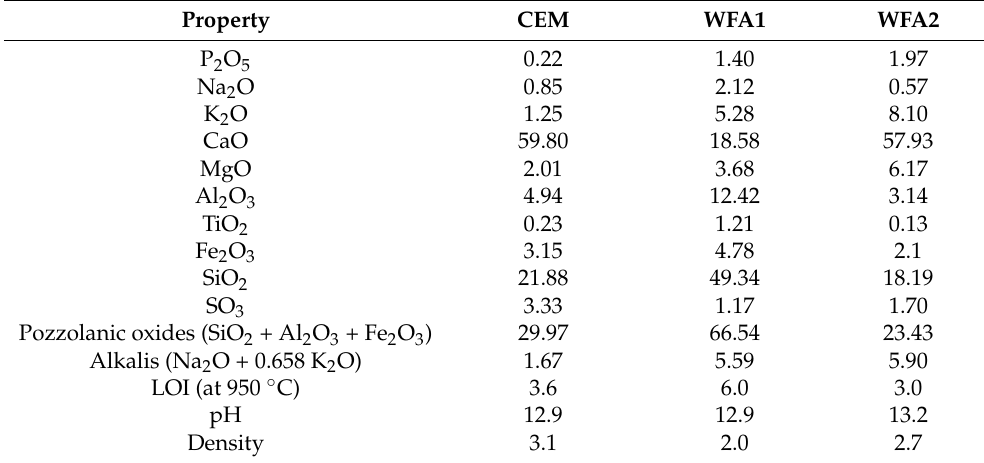
Table 1. Chemical composition and density of the cement and WFA.